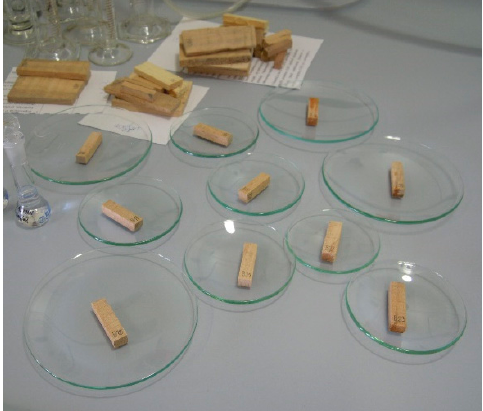
Figure 1. Application of PCP in acetone to model wood samples. The amount of PCP on the model wood samples decreased with time since sample preparation. The main reason was probably evaporation of PCP from the wood, possibly also redistribution into the inner wood structure. No degradation products were observed during chromatographic analyses. The effect of evaporation was reduced by maintaining a time interval of 24 h between PCP application and